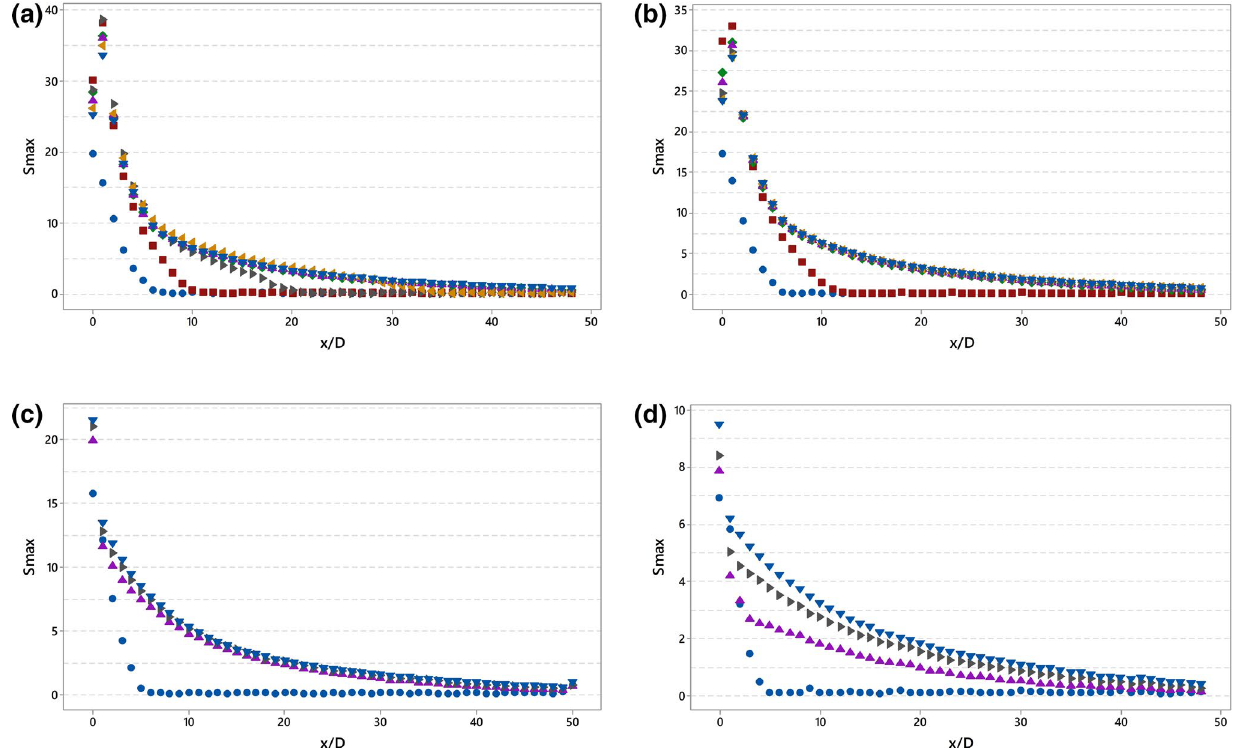
Fig. 7 Maximum swirl angle distribution along the pipe. 5 degrees is the desirable value. a Setup 1; b Setup 2; c Setup 3; d Setup 4. ● Rey = 5000; ■ Rey = 10,000; ♦ Rey = 50,000; ▲ Rey = 100,000; ► Rey = 250,000;◄ Rey = 425,000; ▼ Rey =